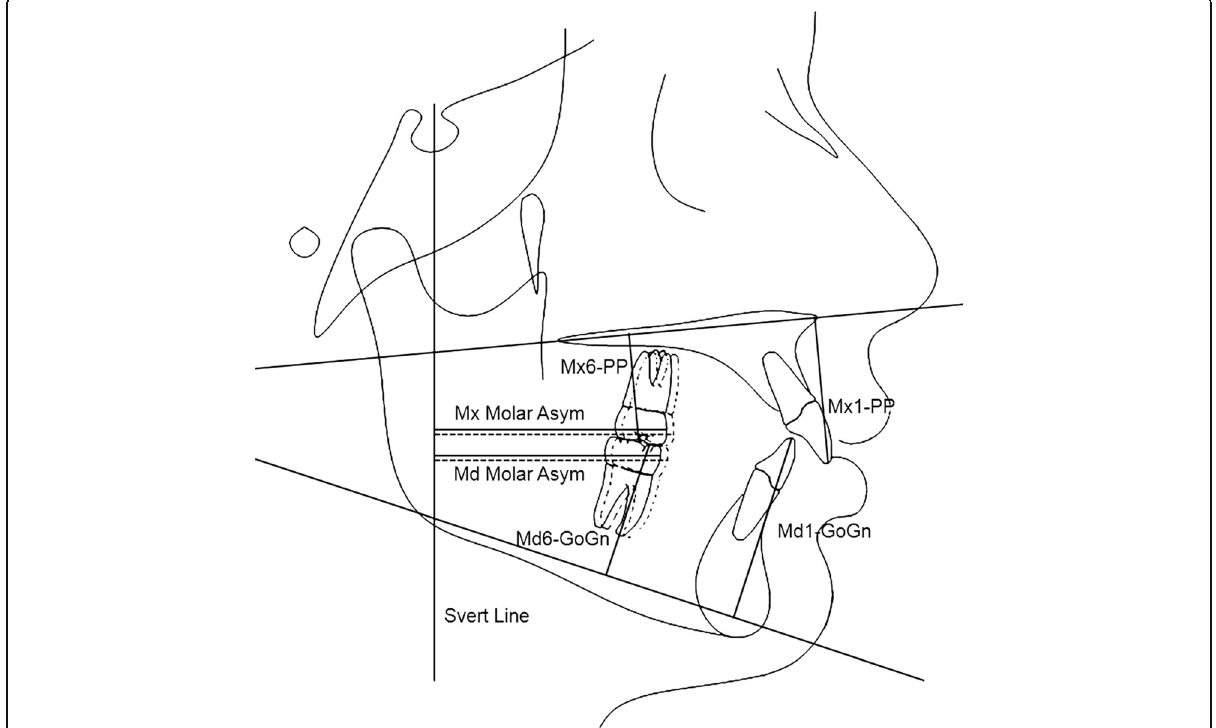
Fig. 3 Skeletal and dental variables. Angular measurements: SNA; SNB; ANB; NAP; SN.GoGn; Mx1.NA; Md1.NB; IMPA. Linear measurements: Co-A; Co-Gn; LAFH; Overbite, Overjet, Mx1-NA; Md1-NB; Mx1-PP; Mx6-PP; Md1-GoGn; Md6-GoGn; Mx Molar Asymmetry; Md Molar